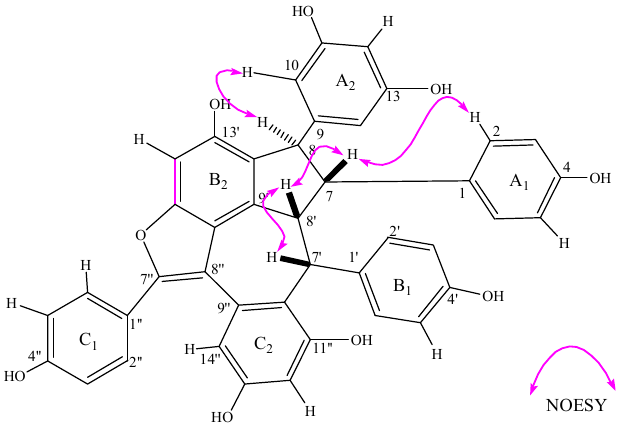
Figure 2. The key NOESY correlations of Compound 1 .